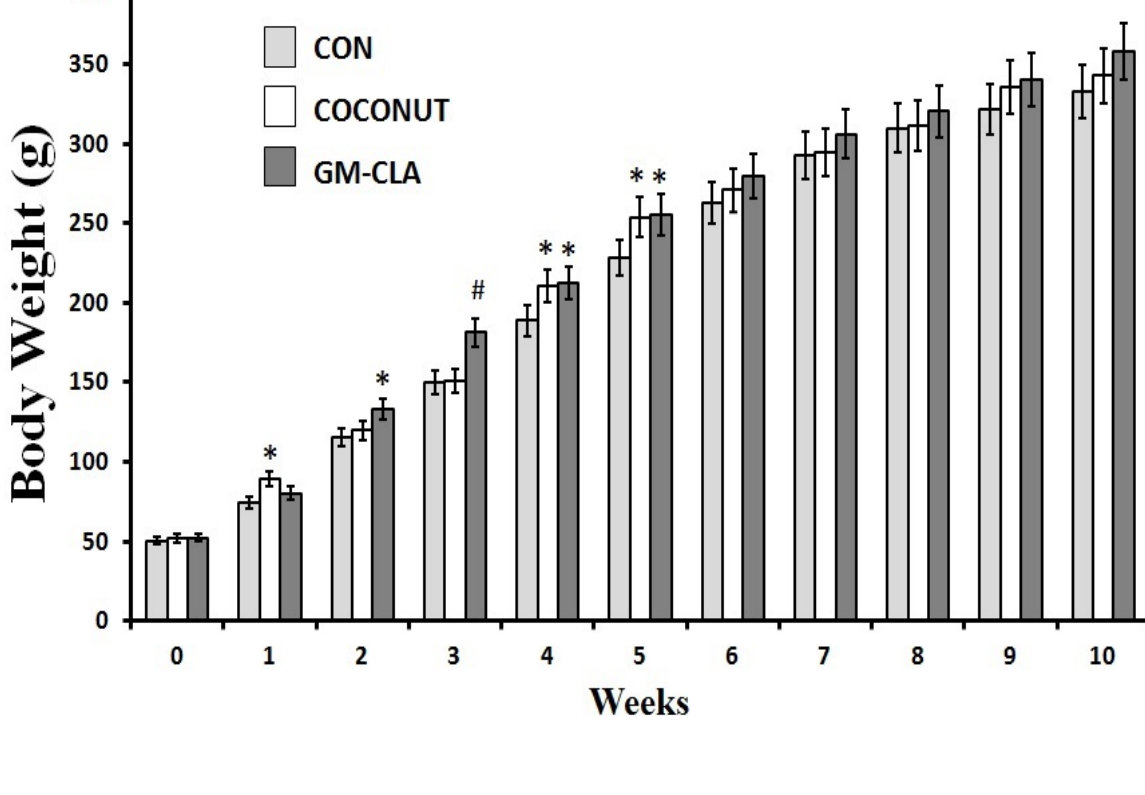
Figure 1. Body weight (g) for each week of experimental treatment (means ± sd). The number of animals in the groups is 12. An (*) denotes a significant difference ( p ≤ 0.05) from control group. An ( # ) denotes a significant difference ( p ≤ 0.05) from control and coconut